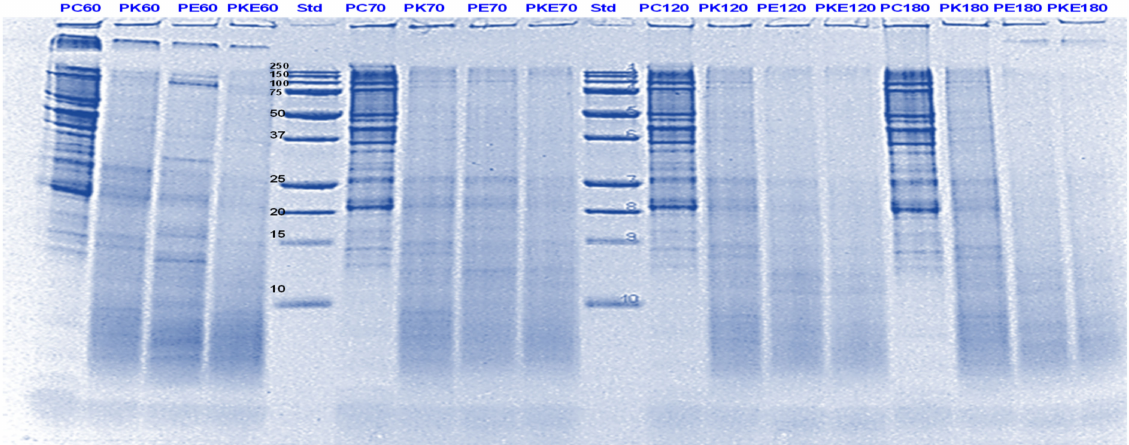
Figure 3. Tricine SDS-PAGE electrophoretogram of pea protein isolate after 60, 70, 120 and 180 min of simulated oral-gastric-small intestinal digestion in the presence or absence of Hayward (K) kiwifruit extract. PC, Pea protein (P) control without any digestive enzymes; PK, with added kiwifruit extract but no digestive enzymes; PE, with digestive enzymes but no added kiwifruit extract; PKE, with both digestive enzymes and green kiwifruit extract. The number 60 is the gastric digestion time following 2 min of oral digestion. Numbers 70, 120 and 180 are the total digestion times in oral-gastro-small intestinal digestion (including 60 min of gastric digestion). Bands (1–10) in the molecular weight